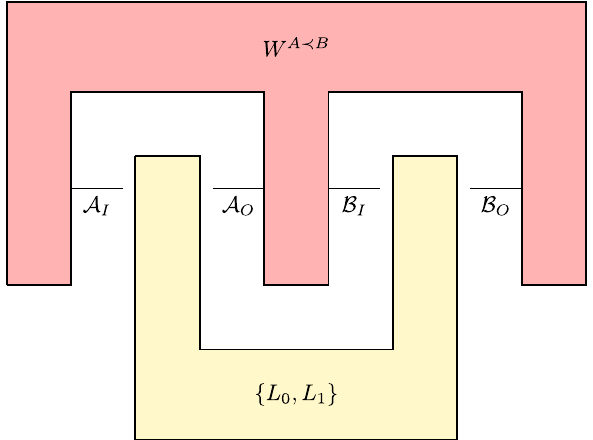
Figure 4. A schematic representation of an adaptive strategy discriminating two process matrices W 0 , W 1 W A ≺ B by using a quantum tester ∈